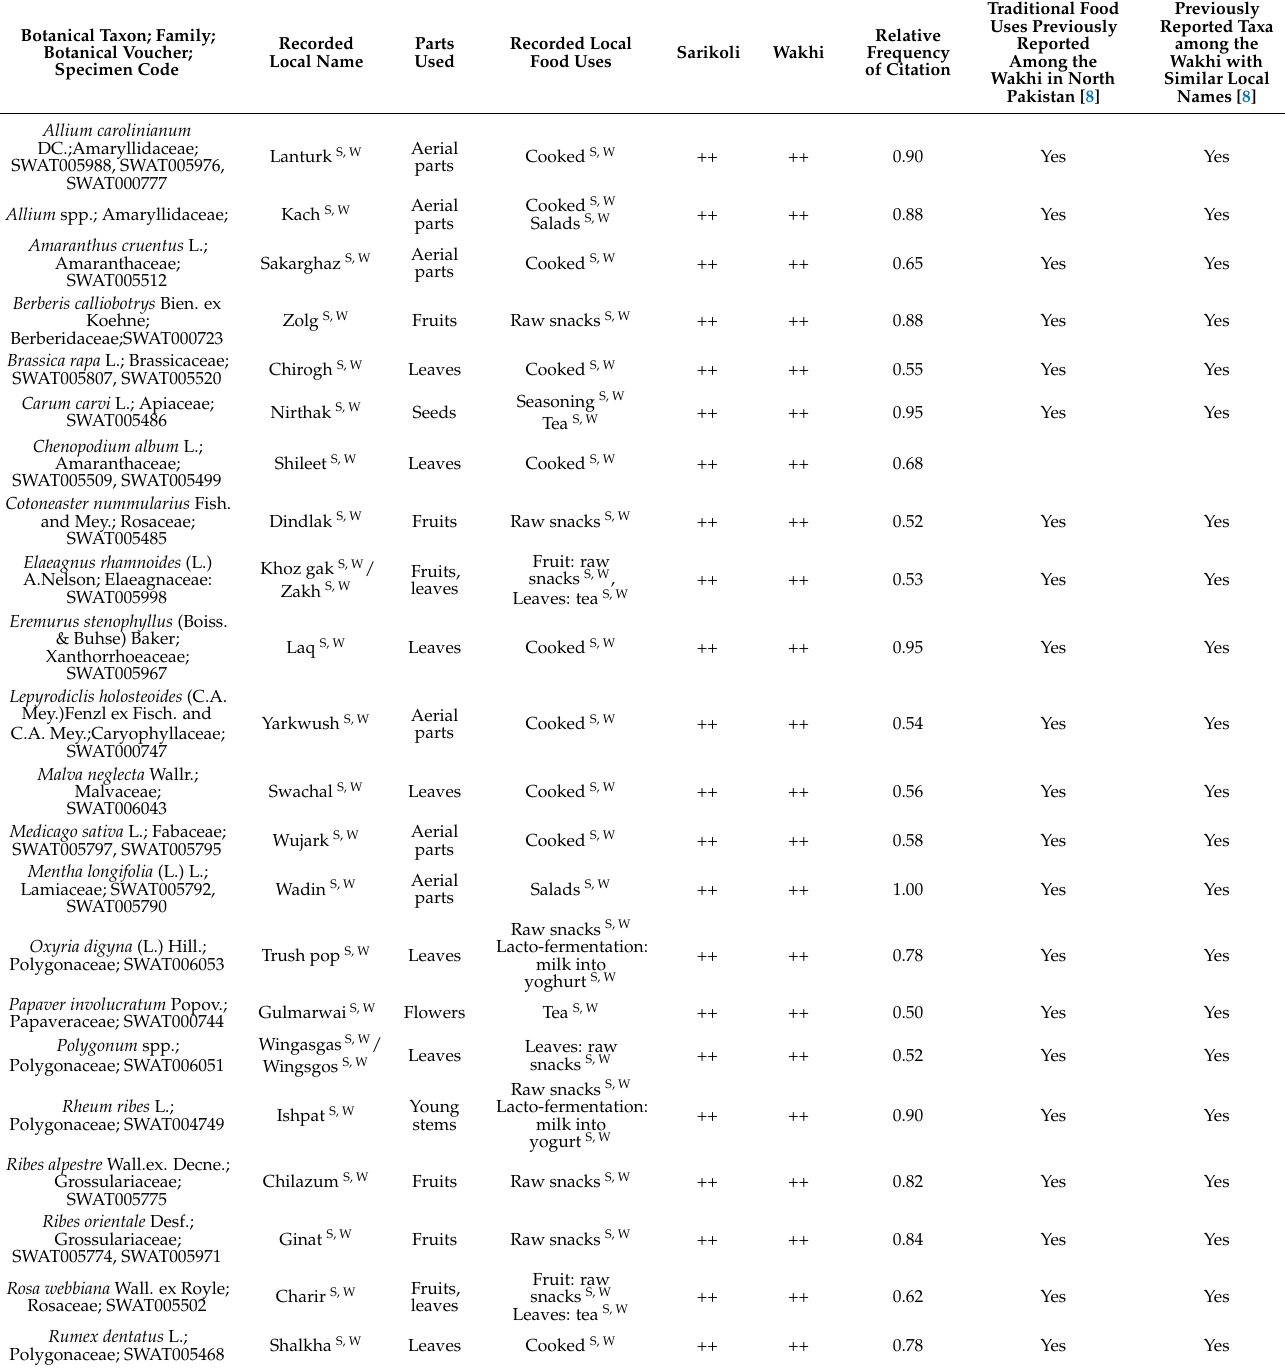
Table 2. Wild food plants gathered among the two studied linguistic